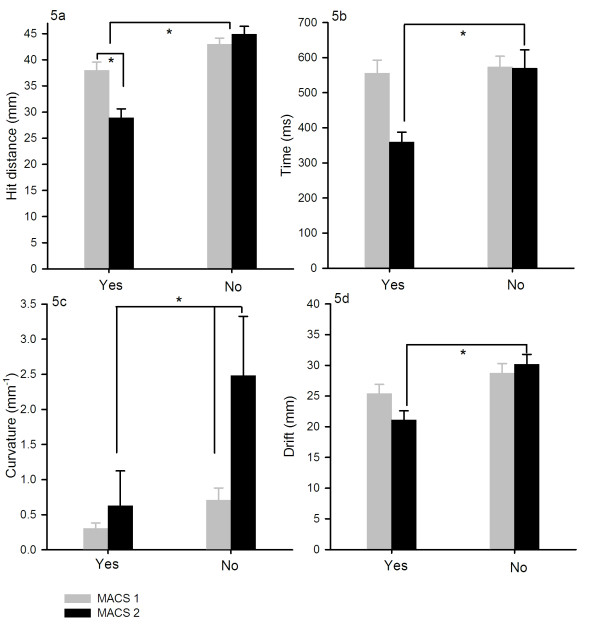
Comparison of motor performance parameters in relation to the CP children's MACS score. Figure 5a, b, c and d depicts the responses for the pooled data from the computer manipulations 10, 15 and 20 degrees divided into the MACS score groups for the CP children. Only the functional measurements where we found a significant difference between the CP children and the healthy groups are displayed. Significant differences between the MACS score and the motor performance parameters (time, curvature and drift) was observed for their responses of subjective reporting of being responsible for the visual object or not (p < 0.033). For time and drift measurements, there is a significant difference between the two MACS groups when reporting either Yes or No, whereas there is a significant difference between the reporting rate depending on the amount of curvature for both MACS score groups.